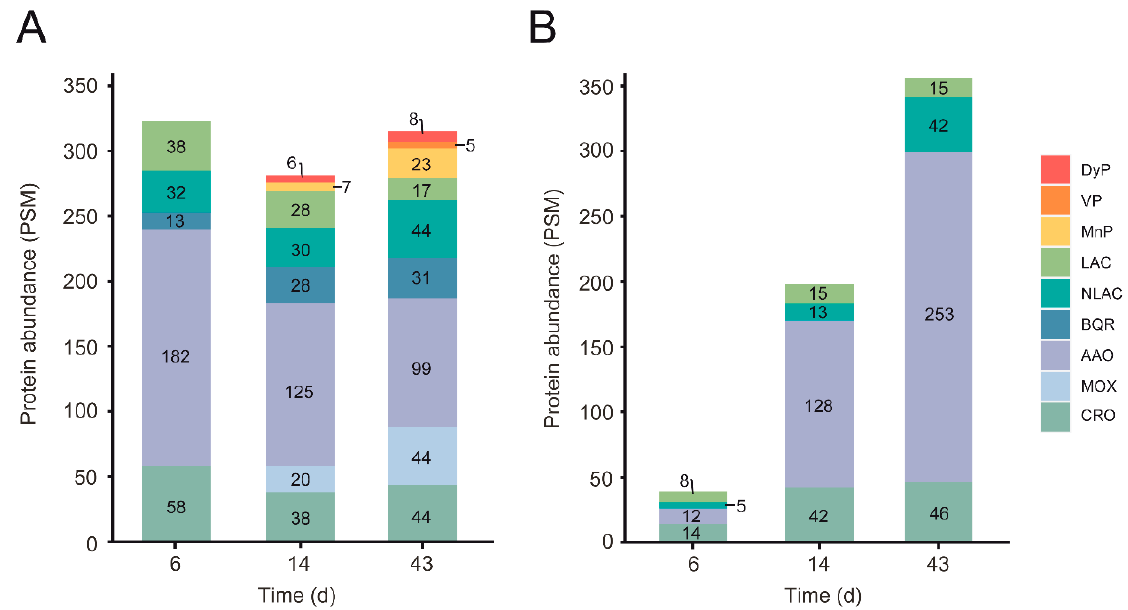
Figure 11. Abundance of main lignin-active oxidoreductases in the wheat–straw ( A ) and glucose–ammonium ( B ) exoproteomes of days 6, 14, and 43. Enzyme families: AAO, aryl–alcohol oxidases; BQR, benzoquinone reductases; CRO, copper-radical oxidases; DyP, dye-decolorizing peroxidases; LAC, laccases; MnP, manganese peroxidases; MOX, methanol oxidases; NLAC, novel laccases; VP, versatile peroxidases.